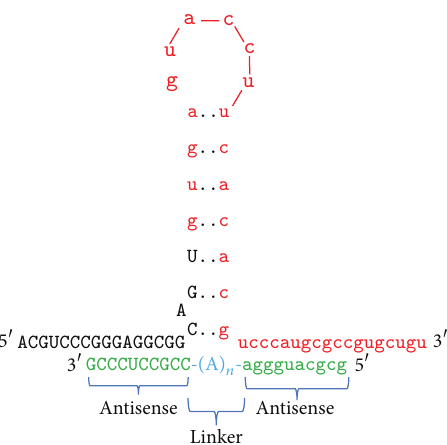
Figure 4: Design of bipartite antisense oligonucleotides targeting the tau RNA stem-loop structure.